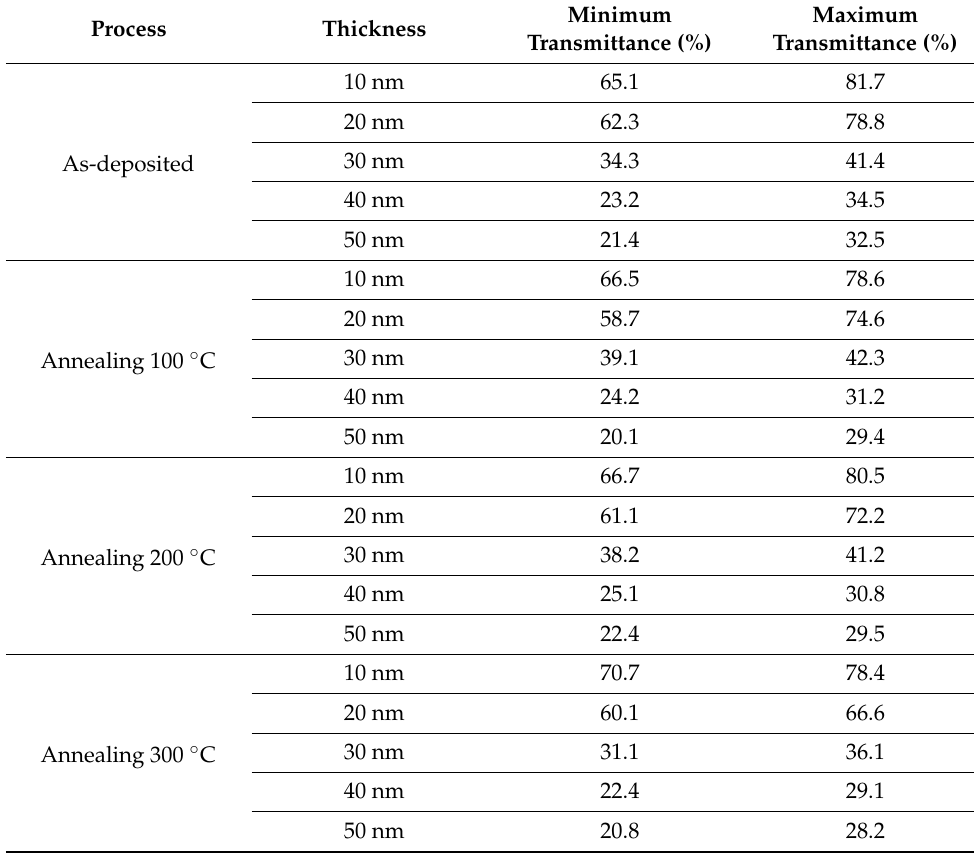
Table 4. Transmittance for Co 40 Fe 40 Y 20 thin